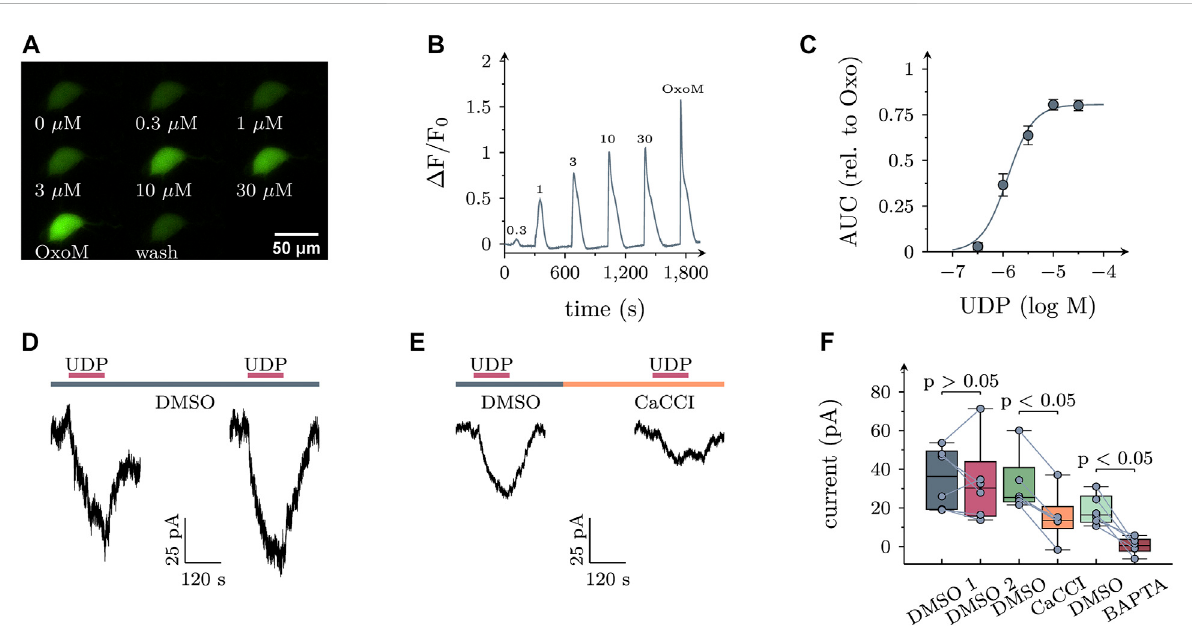
Effects of UDP on intracellular calcium and membrane currents in sympathetic neurons. (A) Example images of an SCG neuron expressing jGCaMP8sstimulatedwiththeindicatedUDPconcentrationsoroxotremorineM(OxoM;10 µM). (B) AveragetimecourseofjGCaMP8s fl uorescence in UDP sensitive cells ( n = 25). Numbers indicate the applied UDP concentration in µM. (C) Concentration dependence of the area under the curve (AUC) of fl uorescence traces shown in (B) relative to the AUC produced by OxoM ( n = 25, logEC50 = − 5.9+/ − 0.06, nH = 1.7, R 2 = 0.67). (D,E) Example voltage clamp recordings of UDP induced currents. (D) UDP (1 µM) was applied twice, interleaved by a 300 s application of the vehicle control DMSO (0.1%). (E) UDPwasappliedinthepresence ofthevehiclecontrolDMSO(0.1%) followed bya300 sapplicationofthespeci fi